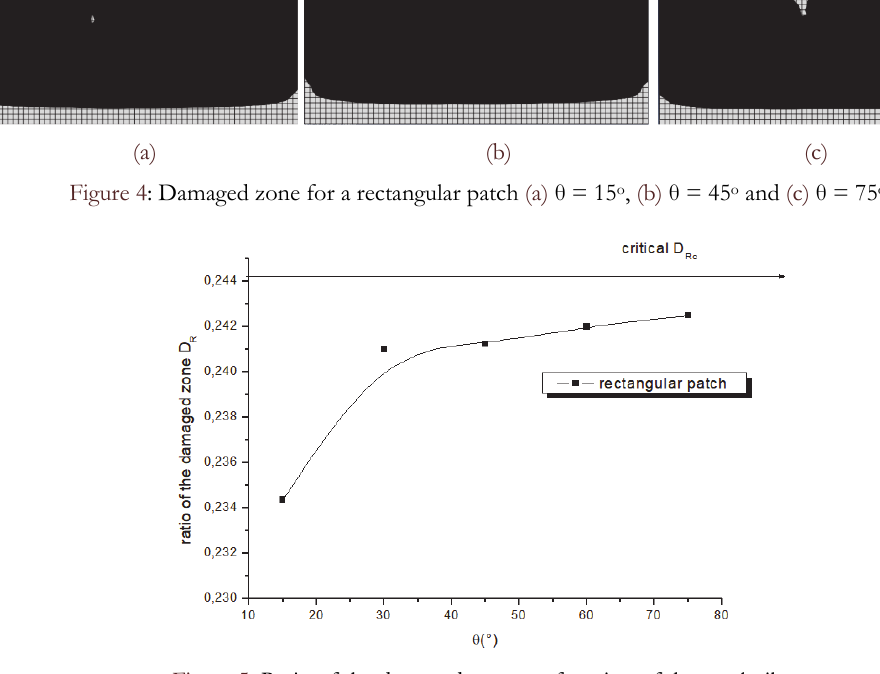
Figure 5: Ratio of the damaged area as a function of the crack tilt.